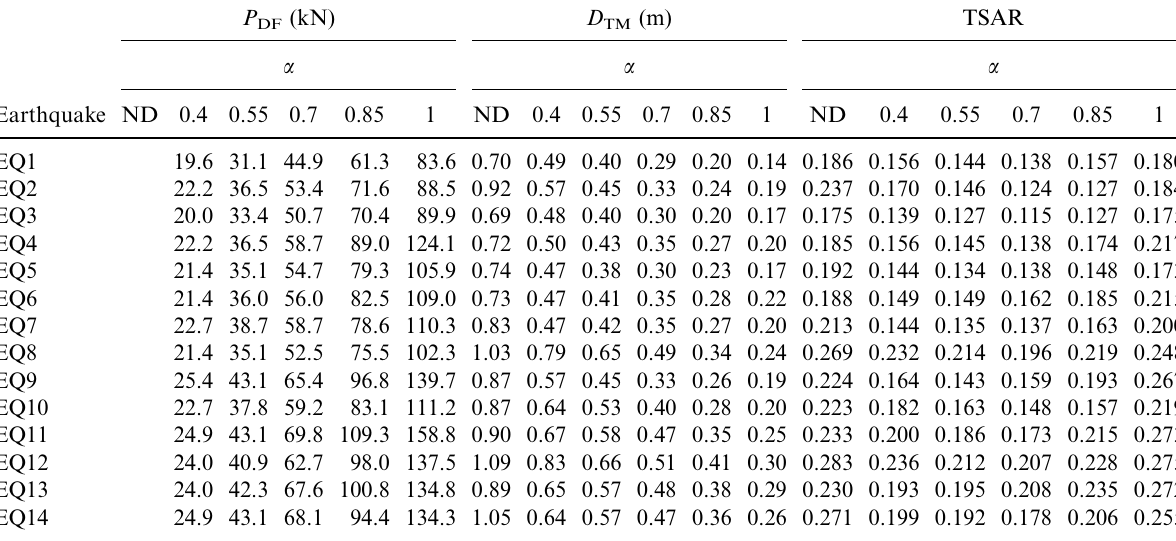
Table 3. Response parameters when C (cid:3) 175 kN-s/m P DF (kN) D TM (m) TSAR a a a Earthquake ND 0.4 0.55